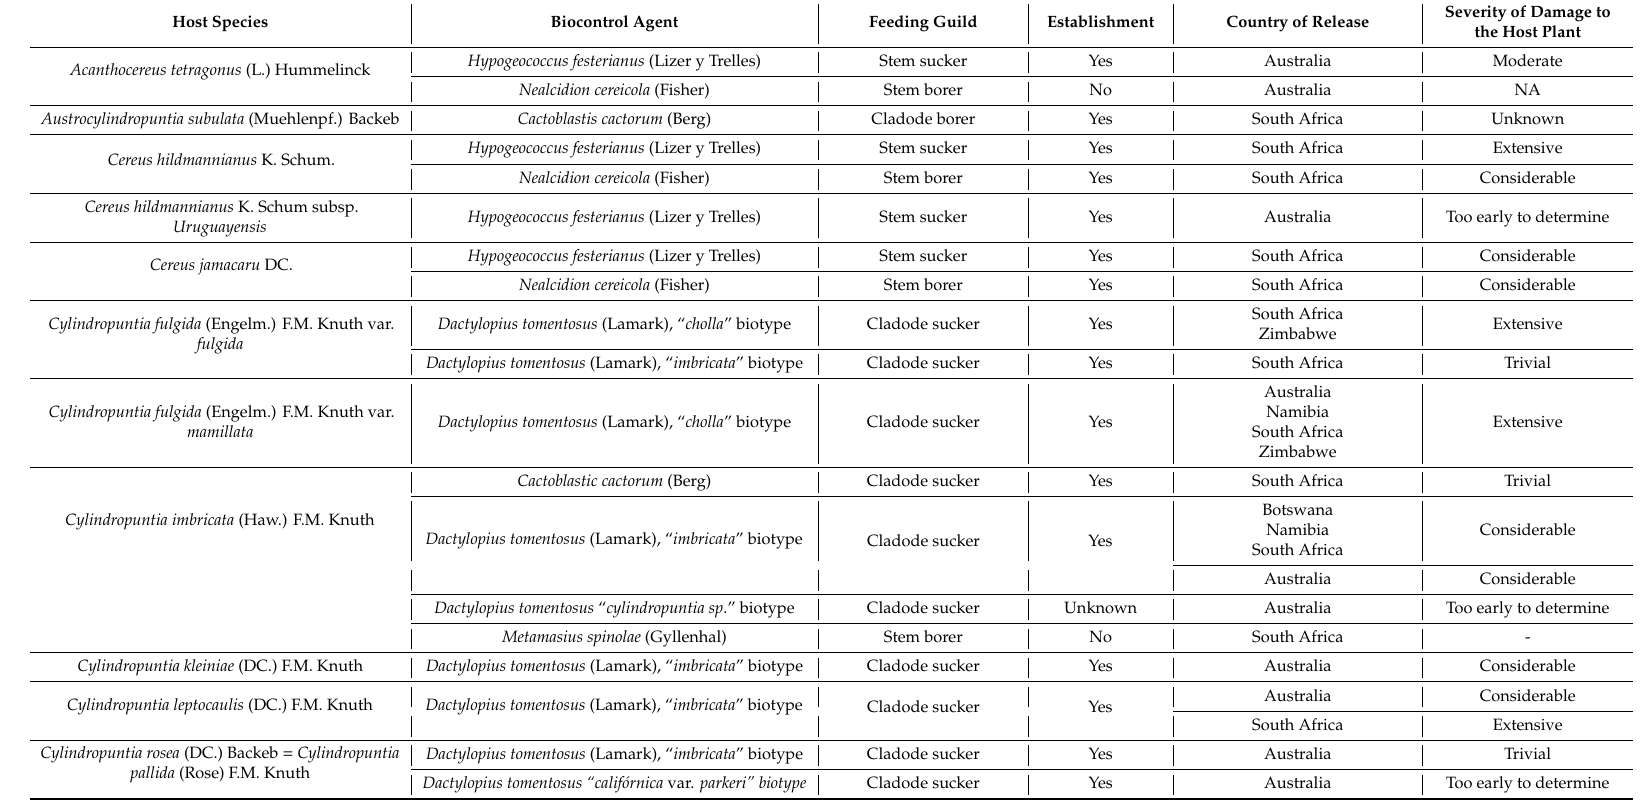
Table 4. A list of all biocontrol agents that have been released against invasive alien cacti based on Klein [85], Winston et al. [21], Zimmermann [68] and Zachariades [76,77], as well as biological control practitioners. The feeding guilds are classified sensu Barbetta [86]. Establishment is categorised as “Yes”, “No” or “Under investigation” depending on whether there is evidence of a self-perpetuating population of the agent after release or on whether this evidence is still under investigation. The severity of damage is rated sensu Olckers and Hill [80] as extensive (very high levels of damage, as much as could be expected from the agent; few plants survive, or growth is arrested, or almost no seeds are produced), considerable (high levels of damage; some plants may survive but growth rates are noticeably slower, or seed production is reduced by more than 50%), moderate (perceivable damage, but most plants survive; growth may be slowed to some extent, or seed production is reduced by less than 50%), trivial (some damage, but survival, growth and seed production of the plants is almost normal), none (no damage) or unknown (agent has been too recently released, or has not been evaluated